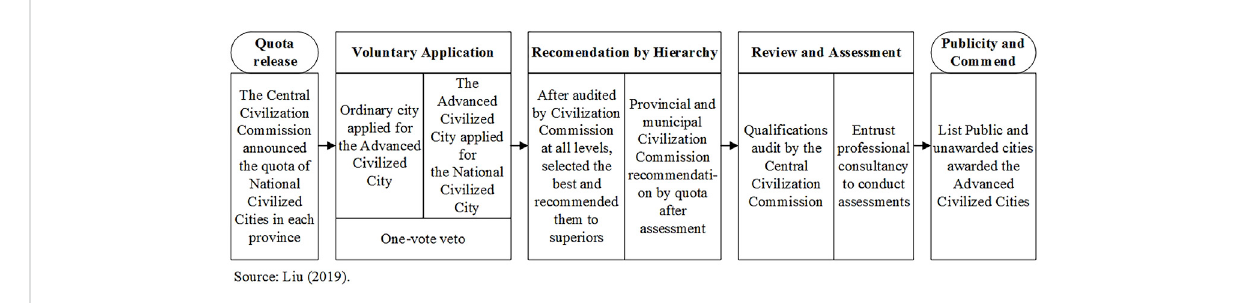
FIGURE 2 The basic process of the national civilized city